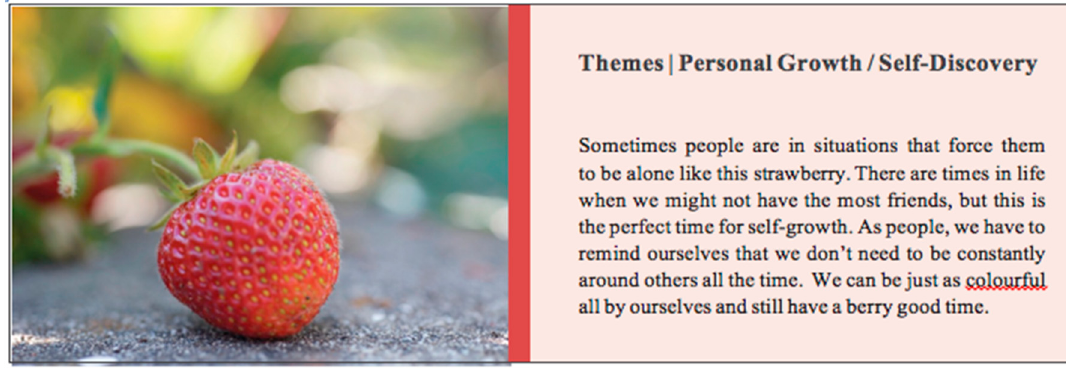
Figure 2. Photovoice artifact #2.